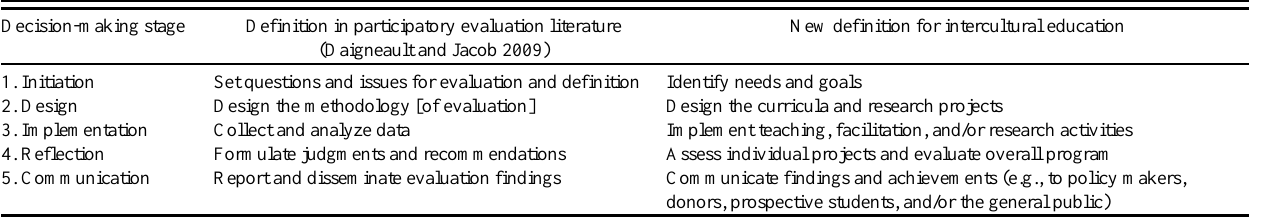
Table 1. Key decision-making stages in intercultural